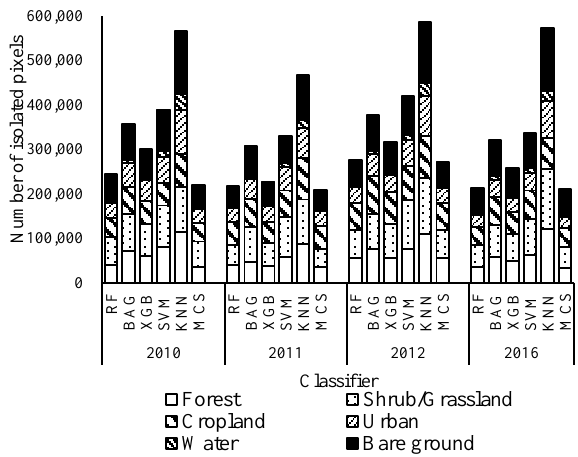
Figure 3. Number of isolated pixels by land cover class for five individual classifiers and MCS aggregation.